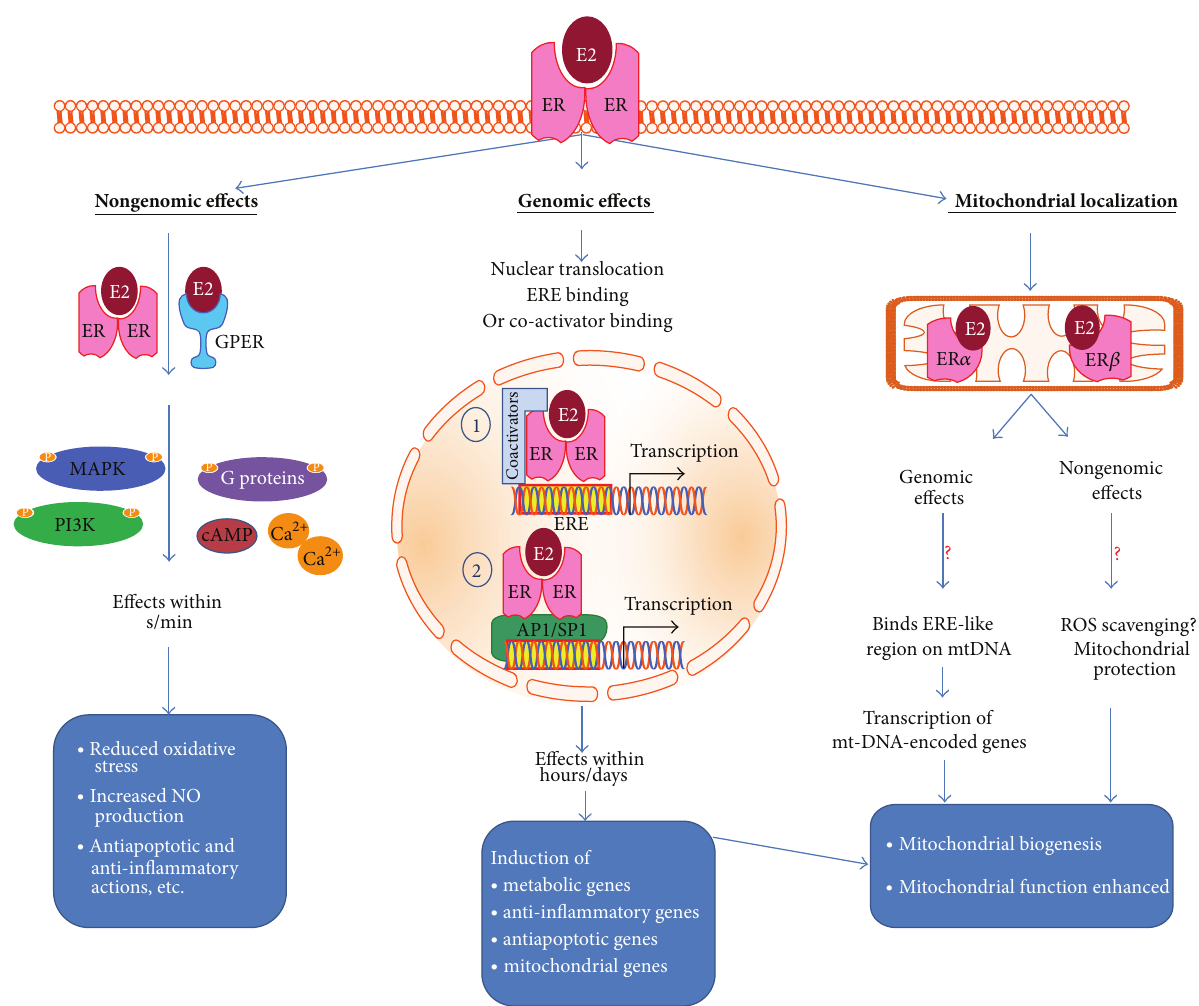
Figure 2: Mechanisms of estrogen action: binding and dimerization of ERs by E2 trigger nongenomic, genomic, and mitochondrial effects. Nongenomic effects may be mediated by E2-ER or by E2 bound to GPER by activating signaling molecules like MAPK, PI3K, G-proteins, and more to elicit immediate actions. Genomic effects are mediated by nuclear translocation of E2-ER complex and either (1) direct binding with estrogen response elements (ERE) along with coactivators to form a transcription complex or (2) binding to transcriptional coactivators to induce gene transcription indirectly. ERs may also localize to mitochondria to induce potentially genomic and nongenomic actions, the mechanisms of which are not well